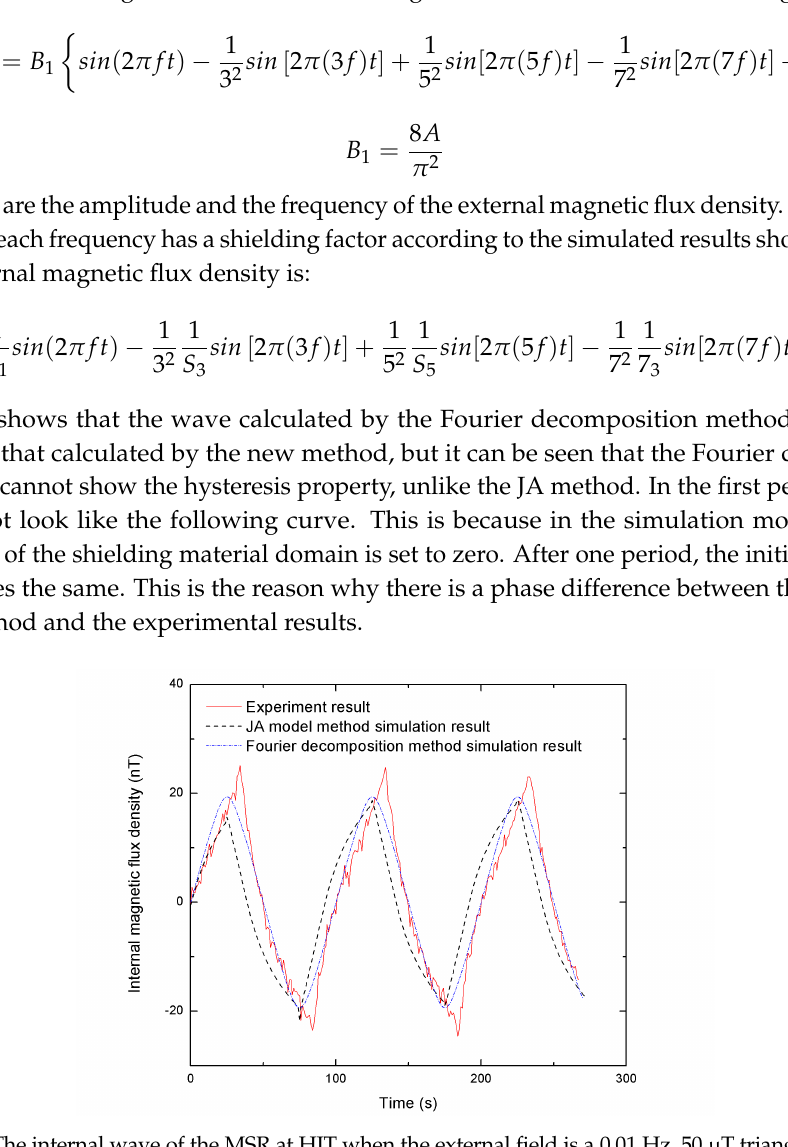
Figure 5. The internal wave of the MSR at HIT when the external field is a 0.01 Hz, 50 µ T triangular